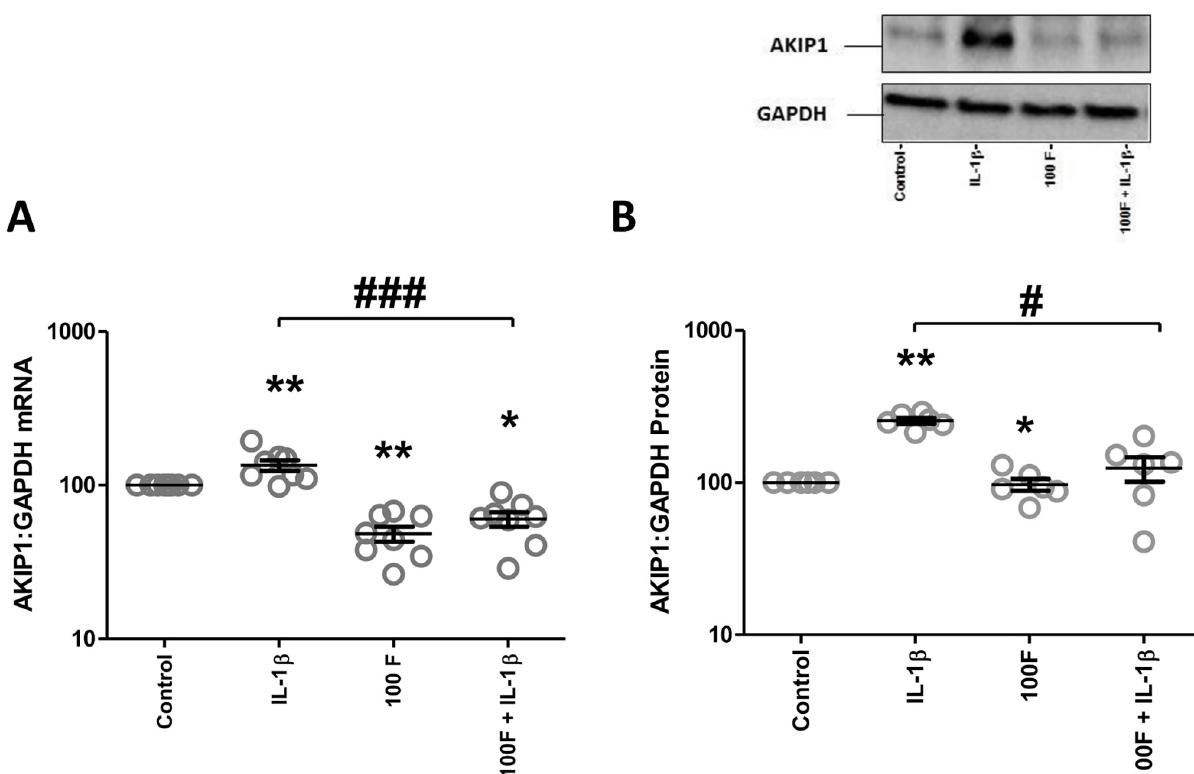
Fig 6. The effect of cAMP in IL-1 β driven AKIP1 gene expression. Myometrial cells were isolated as described in Materials and Methods. The cells were treated with IL-1 β (1ng/mL) and/or forskolin (100 μ M) either alone or in combination for 24h. mRNA and proteins were extracted, and the levels of AKIP1 mRNA expression were measured using quantitative rt-PCR (A) and protein levels are assessed by Western blot analysis (B). Data are shown as the mean and SEM ( � P < 0.05, �� P < 0.01, ��� P < 0.001 when compared to control; #P < 0.05, ##P < 0.01, ###P < 0.001 when IL-1 β is compared to 100F + IL-1 β ), n =